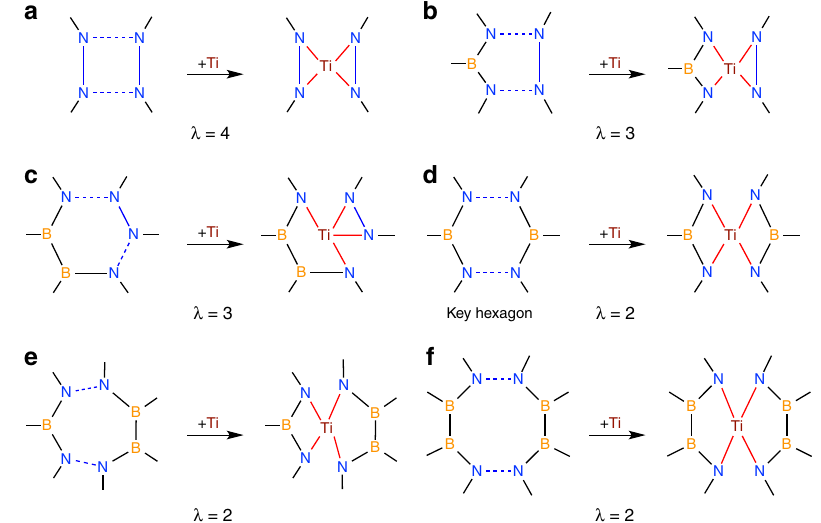
Fig. 4 N – N bond cleavage and Ti – N bond formation schemes upon Ti doping of a BN cage. The additions of a Ti atom to the following faces of the BN cage are considered: a A square with λ = 4, where λ denotes the number of N – N/B – B bonds. b A pentagon with λ = 3. c A hexagon with four N atoms in tandem ( λ = 3). d A key hexagon with two parallel N – N bonds ( λ = 2). e A heptagon with two separated N – N bonds ( λ = 2). f An octagon with two parallel N – N bonds ( λ = 2). The N – N bonds to be broken are indicated by blue dashed lines, while the subsequently formed Ti – N bonds are shown by red solid